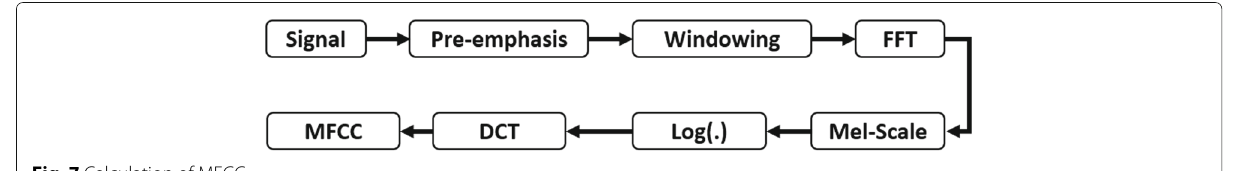
Fig. 7 Calculation of MFCC